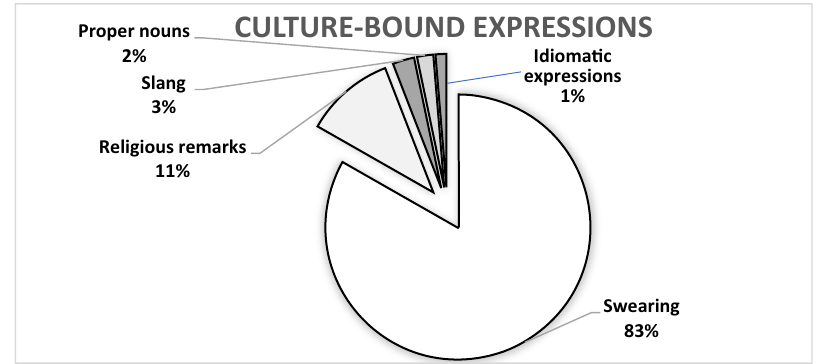
Figure 2: The frequencies of the culture - bound